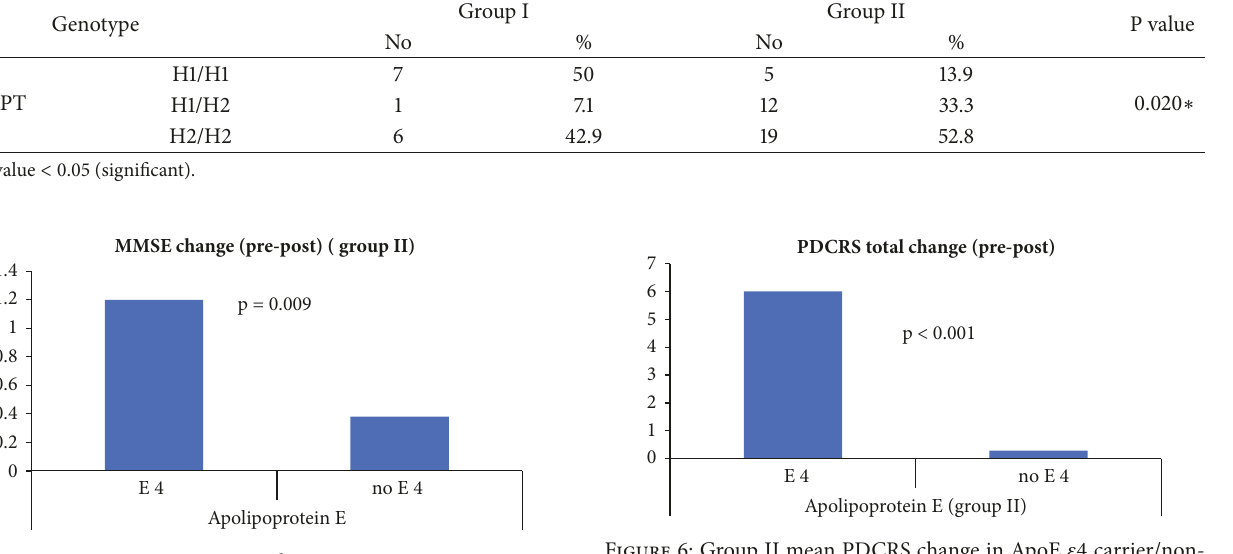
Figure 4: Group II mean MMSE change in ApoE 𝜀 4 carrier/non- carrier.